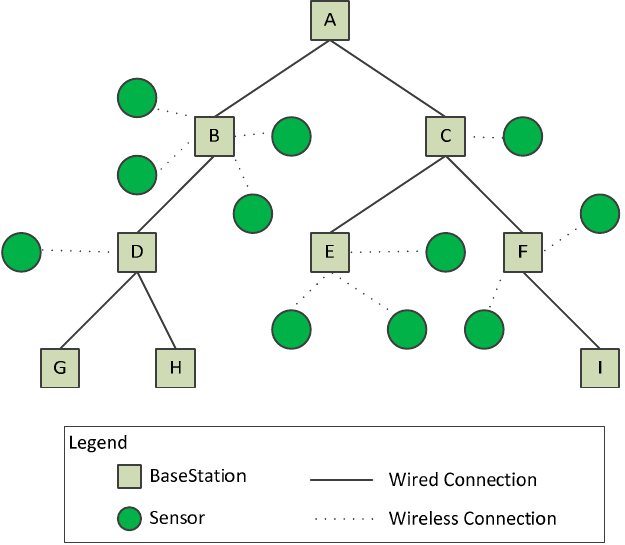
Figure 1. Topology of underground mining (metallic mine).